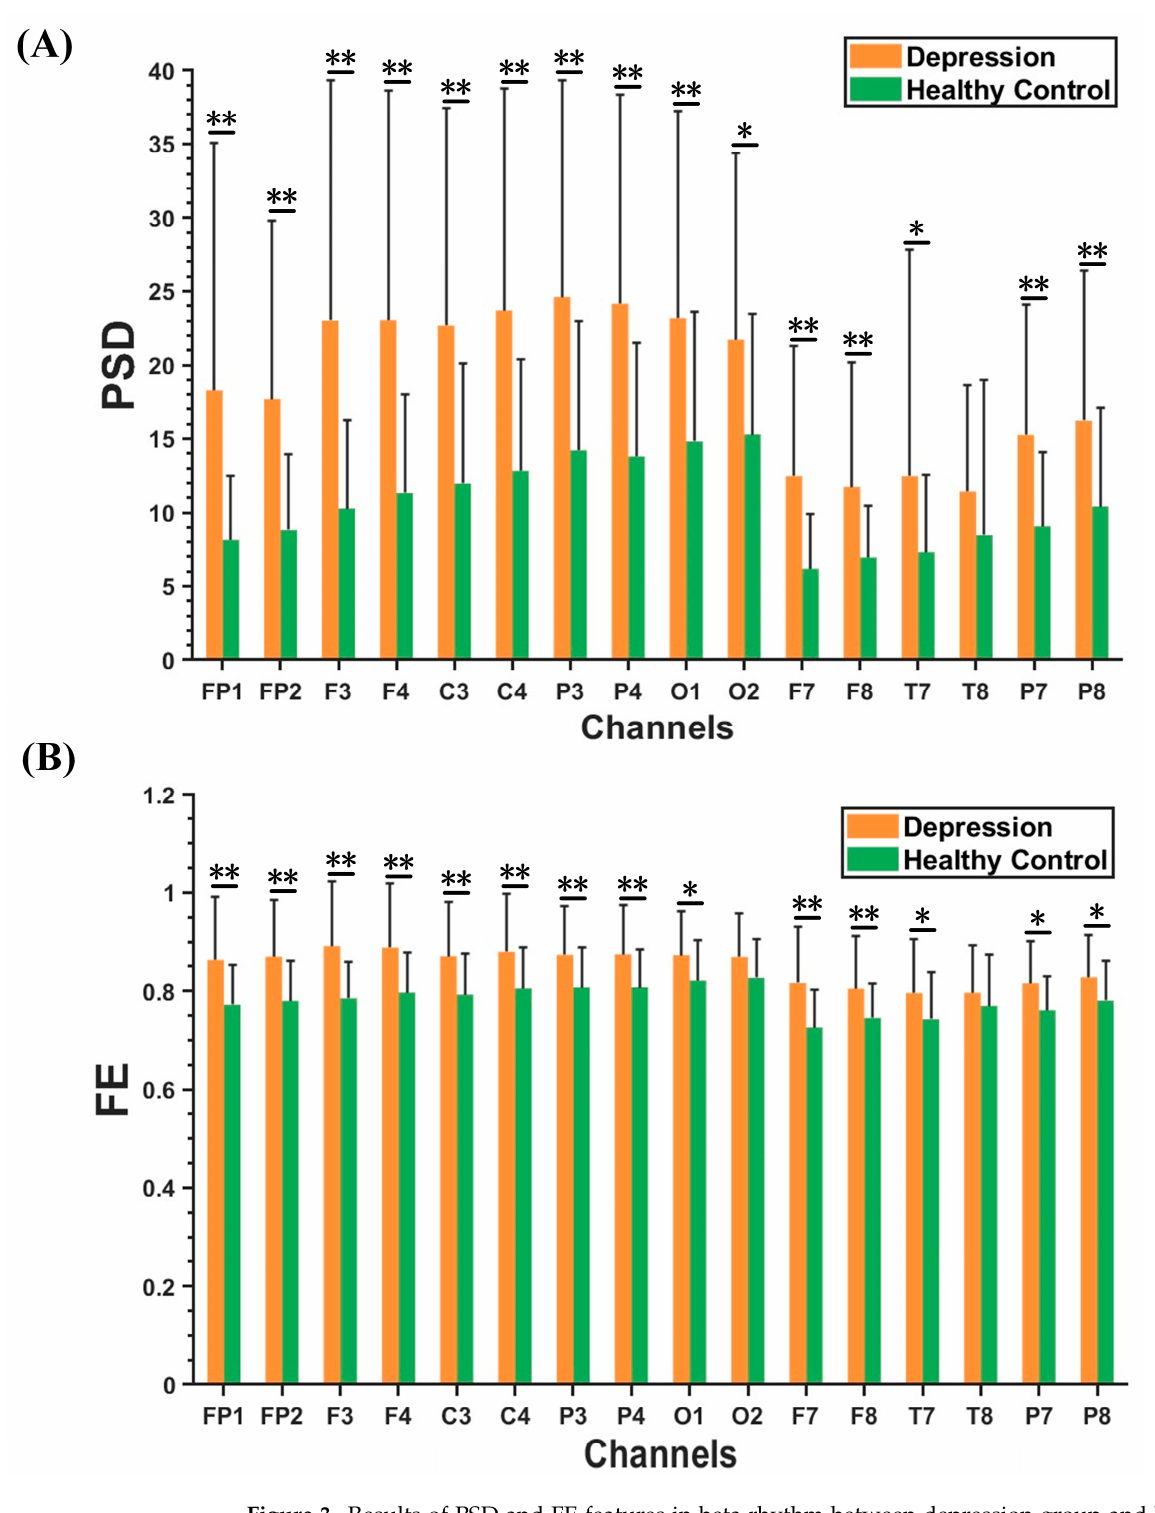
Figure 3. Results of PSD and FE features in beta rhythm between depression group and healthy controls. ( A ) PSD results. ( B ) FE results. The results are given as the mean + standard deviation; * p < 0.05, ** p < 0.01.